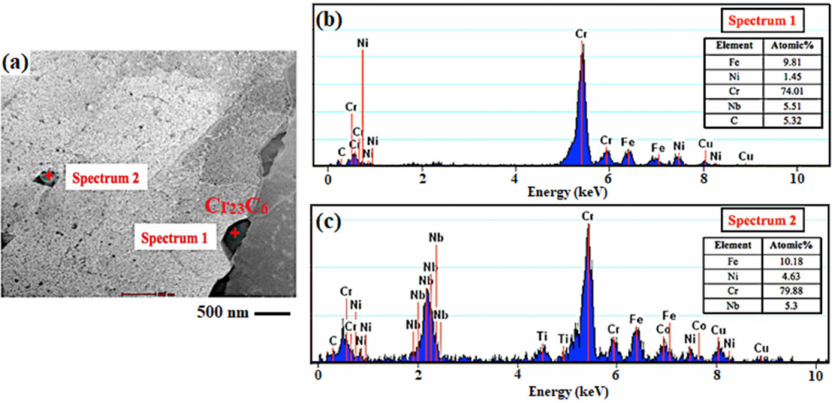
Figure 11. ( a ) TEM images and corresponding EDX spectra of the alloy from ( b ) spectrum 1 and